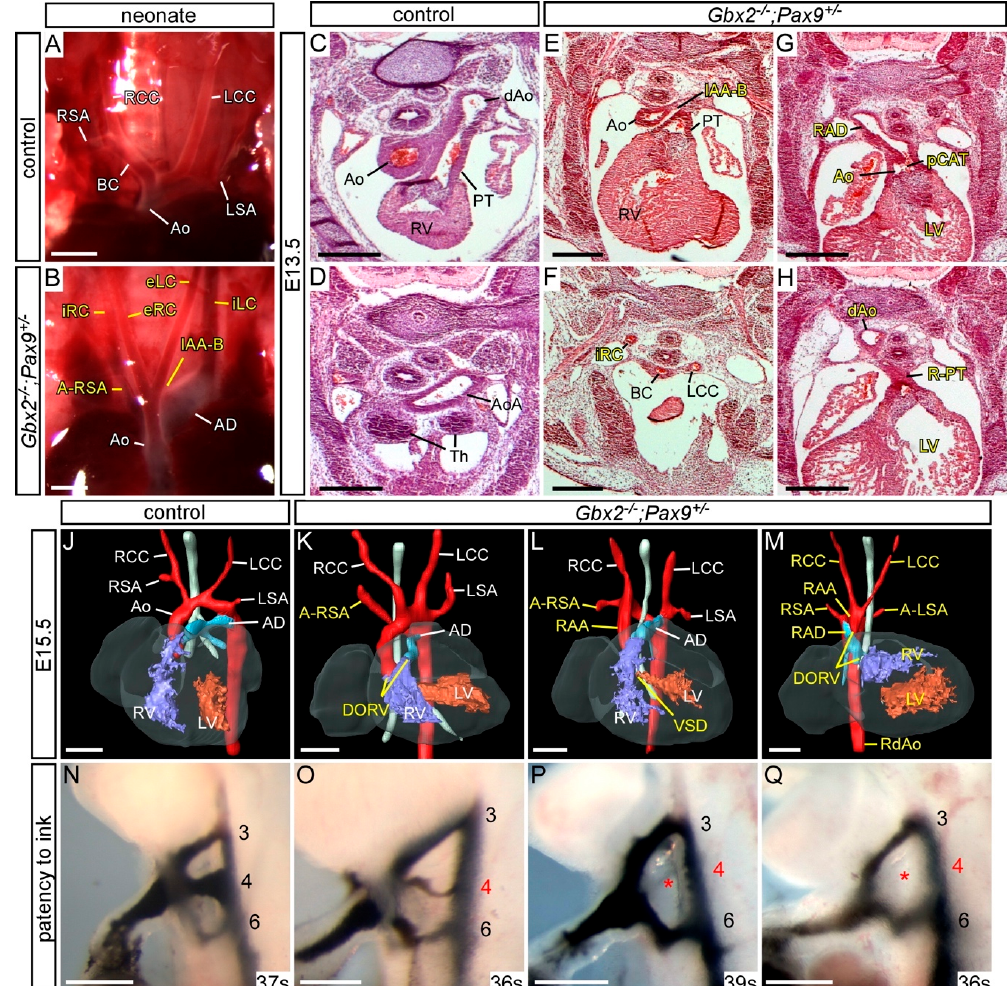
Figure 4. Cardiovascular defects in Gbx2 − / − ;Pax9 +/ − mice. ( A – B ) Neonates were dissected on the day of birth. ( A ) Arch arteries of control neonates were normal. ( B ) One Gbx2 − / − ;Pax9 +/ − neonate found dead on the day of birth displayed IAA-B and an aberrant left and right internal and external carotid artery (iLC, eLC, iRC, eRC). ( C – H ) H&E stained transverse sections of E13.5 embryos (n = 5). A normal outflow tract ( C ), aortic arch (Ao) and thymus (Th; D ) are seen in control embryos. In two Gbx2 − / − ;Pax9 +/ − mutant embryos ( E – H ) the defects include IAA-B ( E ), an aberrant right internal carotid artery (iRC; F ), and a partial common arterial trunk (pCAT) emerging from the left ventricle ( G ). The pulmonary trunk is right-sided (R-PT; H ) and the aorta was interrupted (not shown). The thymus is absent in both mutants ( F , H ). ( J – M ) 3D reconstructions of MRI datasets of hearts from a normal control embryo ( J ) and Gbx2 − / − ;Pax9 +/ − mutant embryos (n = 8). Defects include aberrant right subclavian artery (A-RSA; K , L ), double outlet right ventricle (DORV; K , M ), right-sided aortic arch (RAA; L , M ). Situs patterning defects were also observed, including mirror image aortic arch arteries (RAA, RAD, RdAo) with aberrant left subclavian artery (A-LSA) and aberrantly positioned ventricles ( M ). ( N – Q ) Intracardiac ink injection into E10.5 embryos (35–39 somites). ( N ) In control embryos, PAAs 3–6 are patent to ink. ( K , L ) In Gbx2 +/ − ;Pax9 +/ − embryos (n = 7), all had an aberrant 4th PAA including hypoplastic ( O ) or non-patent to ink ( P , Q ; asterisk) vessels. Scale bars: 1 mm in ( A – B ); 500 µ m in ( C – Q ). Abbreviations: Ao, aorta; AD, arterial duct; dAo, dorsal aorta; LCC, left common carotid artery; LSA, left subclavian artery; LV, left ventricle; PT, pulmonary trunk; RCC, right common carotid artery; RSA, right subclavian artery; RV, right ventricle; s, somites. The somite numbers given in the legend reflect the range analysed for the whole study. The figure contains representative images